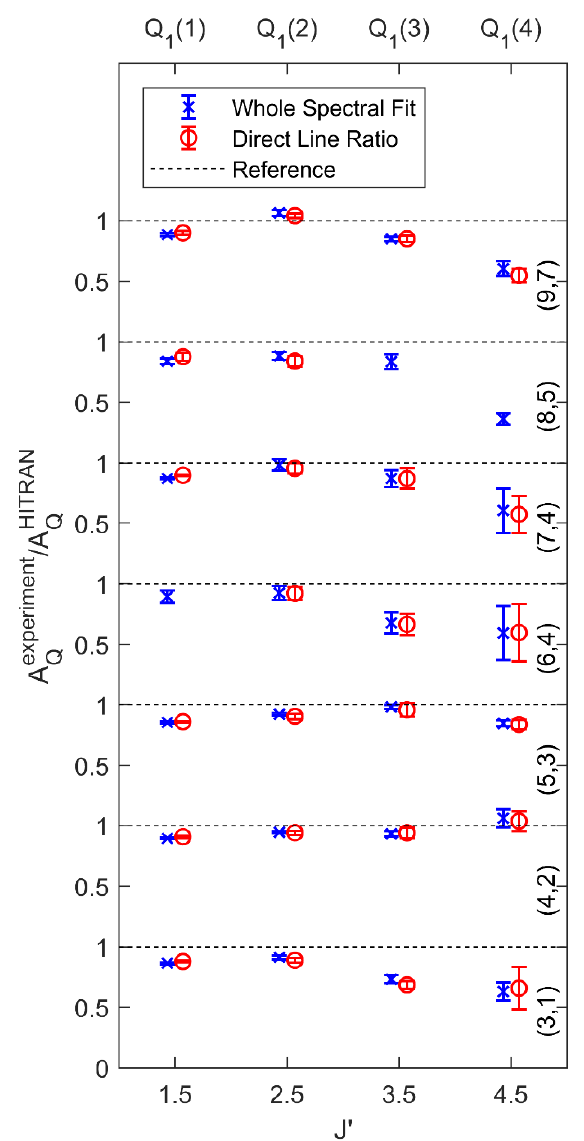
Figure 3. Ratio of the measured Einstein coefficients relative to those reported in the HITRAN database. The first four Q 1 -branch lines of the seven Meinel transitions are shown. The red circles are those determined using the direct line ratio method, while the blue crosses represent those determined from the spectral fit method. The error bars represent twice the standard error of the mean.